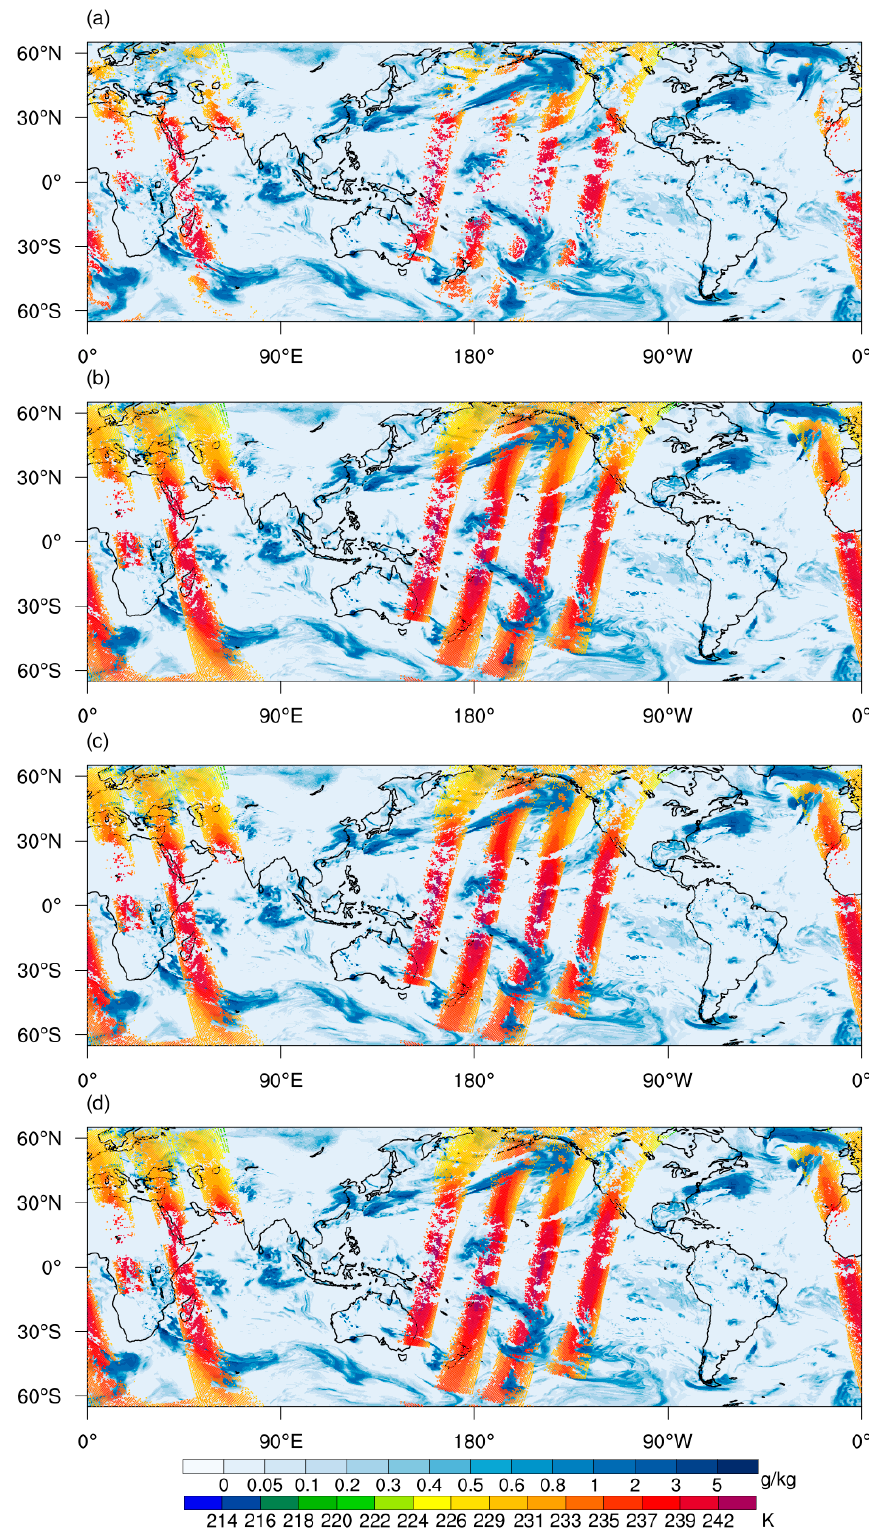
Figure 8. Spatial distribution of observations from channel 5 remaining at 1200 UTC on December 10, 2018, after application of DCS for the ( a ) CTRL, ( b ) DCS05, ( c ) DCS10, and ( d ) DCS20 experiments. The cloud mixing ratio obtained from the Global Forecasting System (GFS) analysis is depicted as a color-coded background that indicates the global distribution of cloud